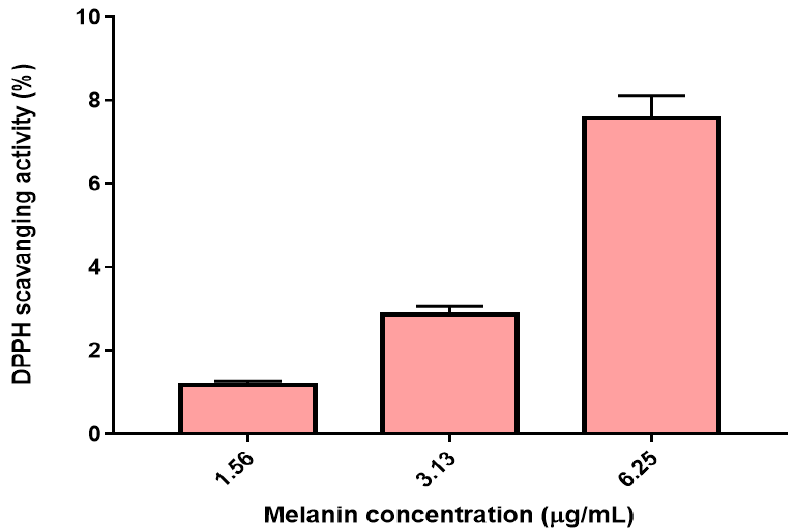
Figure 8. The scavenging ability of the melanin produced by G. oxydans FBFS 97 on DPPH radicals. Table 3. The IC 50 value was defined as the concentration of G. oxydans FBFS97 melanin.